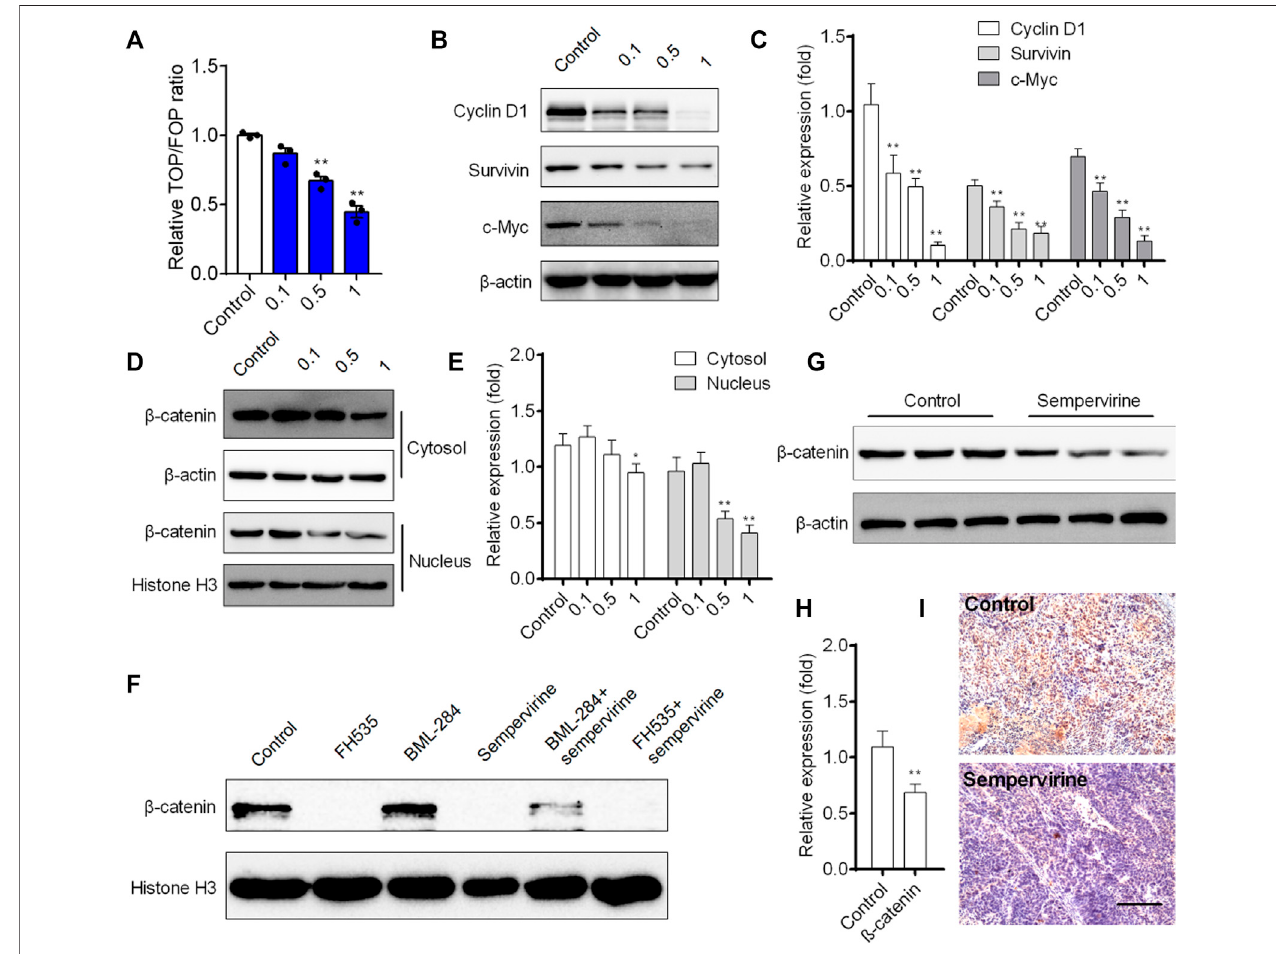
FIGURE 7 | Sempervirine inhibited Wnt/ β -catenin pathway and induced apoptosis in vivo . (A) Cells were treated with different concentrations of sempervirine for 24 h to TOP fl ash assay. (B, C) Western blotting analysis of Wnt/ β -catenin target genes survivin, cyclin D1, and c-Myc in HepG2 cells after treated with different concentrations ofsempervirine. (D, E) HepG2 cells were pretreated with sempervirine for 24 h and the fractioned lysates were analyzed by Western blotting. (F) HepG2 cells treated with 10 μ M Wnt activator BML-284 or 10 μ M Wnt inhibitor FH535 for 24 h in the presence of sempervirine were analyzed by western blots. (G – I) The effect of sempervirine on the expression of β -catenin protein in vivo . Scale bars (cid:2) 100 μ m. Data are presented as means ± SEM. * p < 0.05; ** p < 0.01 vs . Control.